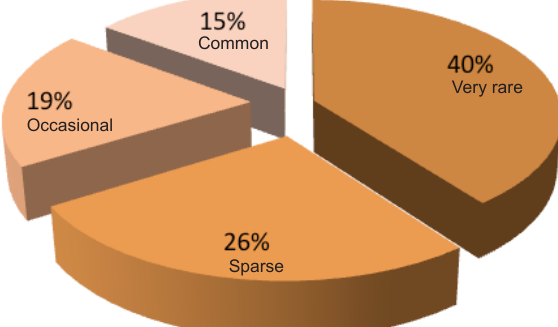
Figure 1. Status representations of orchids (n = 221 species)